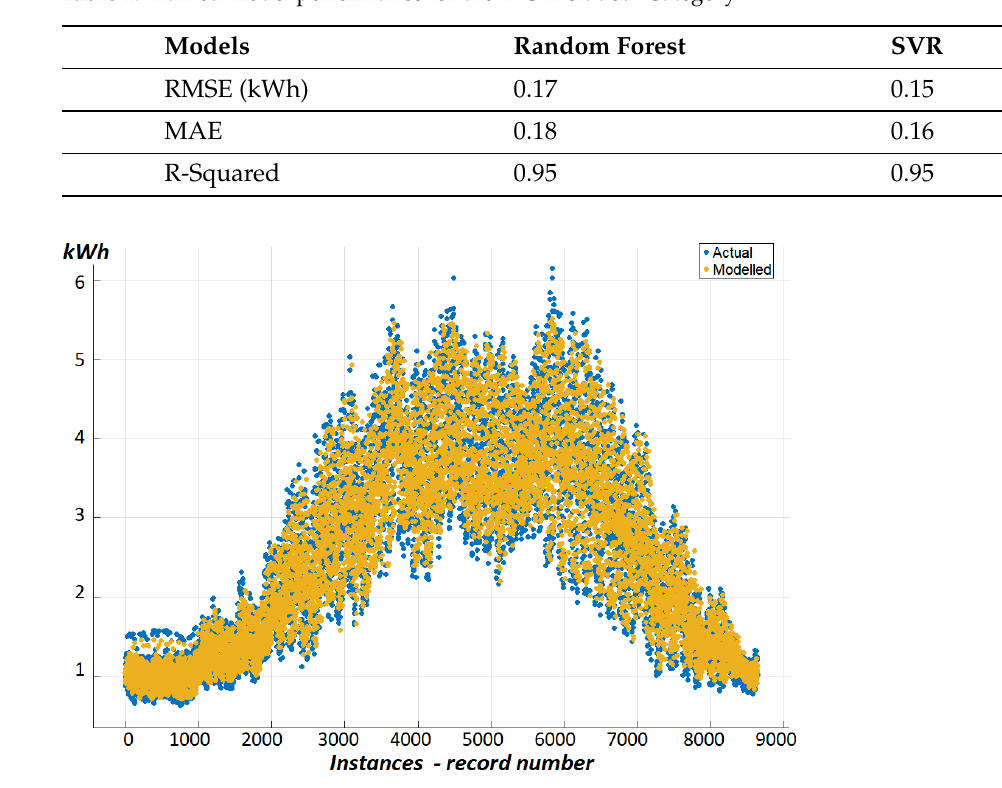
Table 1. Trained model performance for the ‘AC-included’ Category.